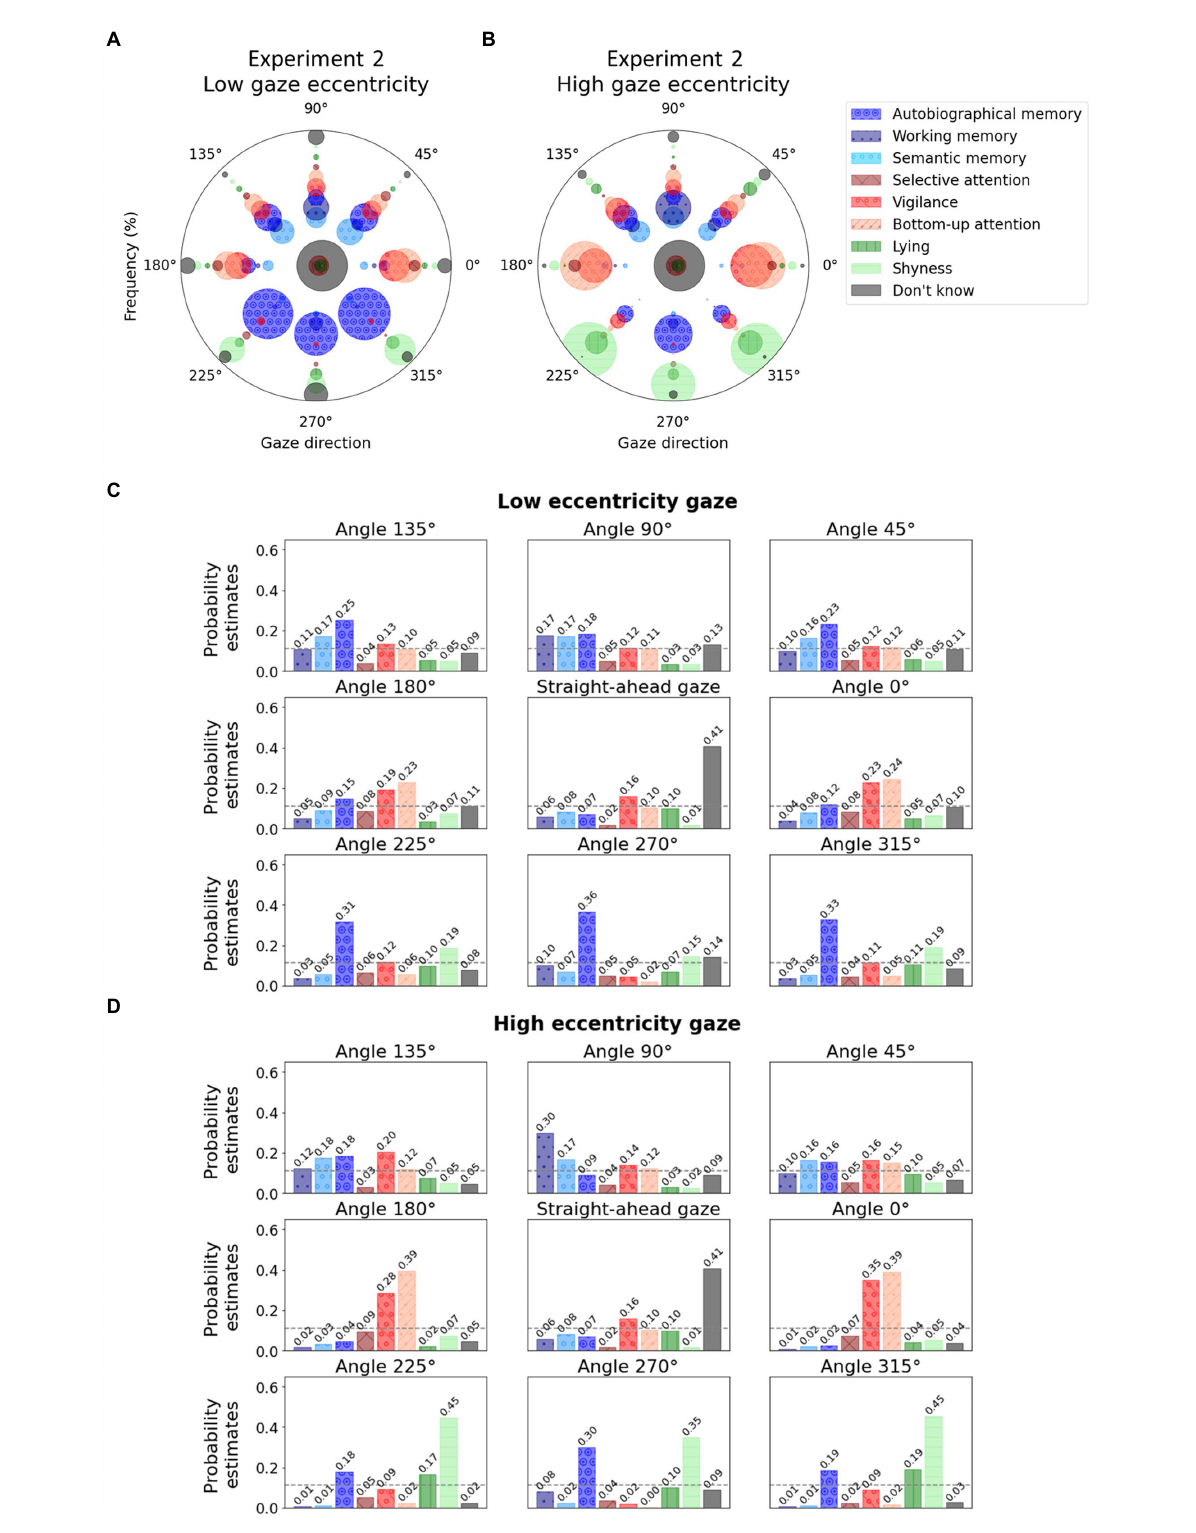
FIGURE 4 Polar graphs in which each angle represents a gaze direction. (A) For each gaze direction, the radii of the bubbles represent the frequency at which a given mental state (see colors) was associated with the given gaze direction during Experiment 2 for the condition with low gaze eccentricity (for examples of stimuli, see Figure 2); (B) For each gaze direction, the bubble radii represent the frequency at which a given mental state (see colors) was associated with the given gaze direction during Experiment 2 for the condition with high gaze eccentricity. (C) Low eccentricity condition. The bars represent the probability estimates from the multinomial logistic regression for each mental state. The dashed gray lines represent chance level (i.e., 0.11). (D) High eccentricity condition. For graph conventions and legend, see Figure